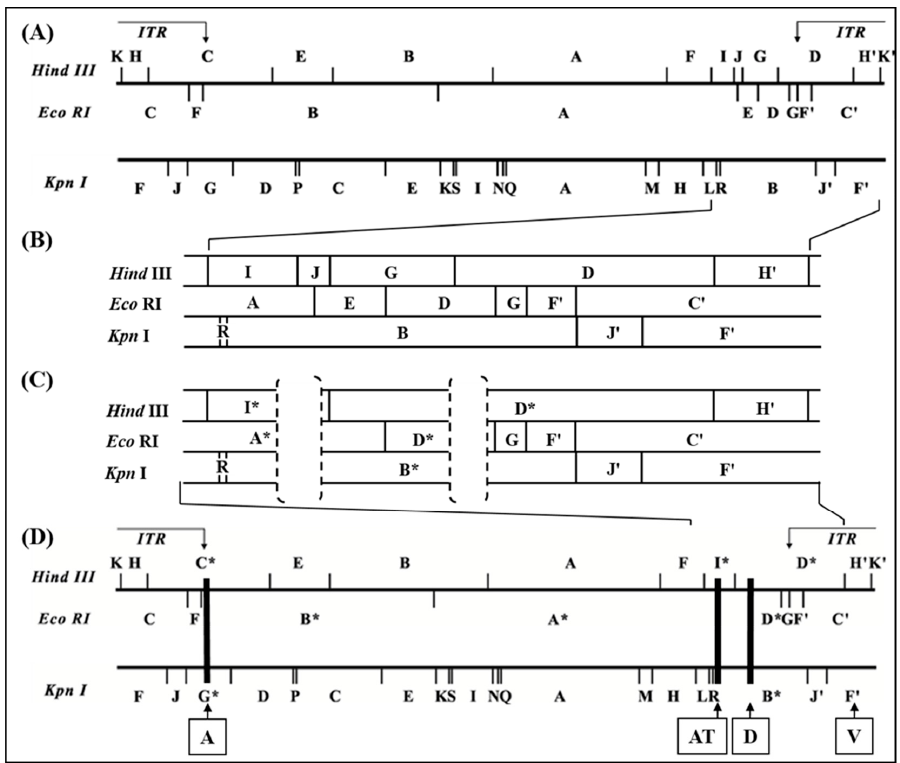
Figure 2. Map locations of the deleted parts of the D1701 ‐ V genome. The genomic map of the Hin dIII ‐ , Eco RI ‐ and Kpn I ‐ fragments of D1701 ‐ B ( A,B ) and D1701 ‐ V ( C,D ) is depicted. ITR indicate the inverted terminal repeats at the genomic termini. In ( B ) and ( C ) the sequenced right ‐ hand terminus of D1701 ‐ B and D1701 ‐ V is shown enlarged. The regions AT and D deleted in D1701 ‐ V are indicated by dashed brackets. Those DNA fragments affected by the genomic deletions are marked by stars. ( D ) The black rectangles indicate the deleted regions A, AT and D in D1701 ‐ V; in addition, the earlier described insertion site V ( vegf ‐ e gene) is